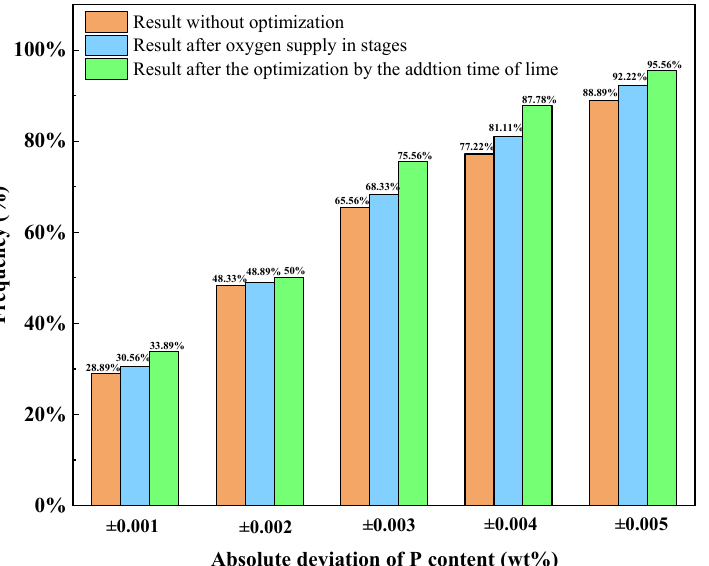
Figure 12. Frequency of absolute deviation of P content in the prediction model before and after optimization.